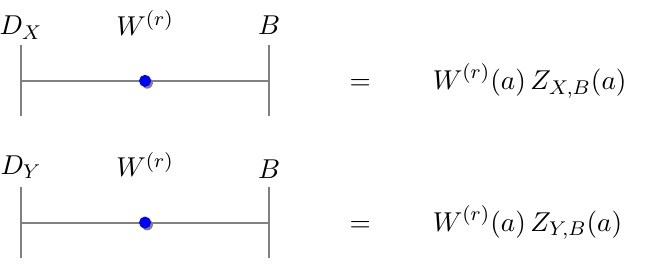
B 1 ; B 2 by inserting cutting the path h i ( a ) and Z X;B ( a ). 1 2